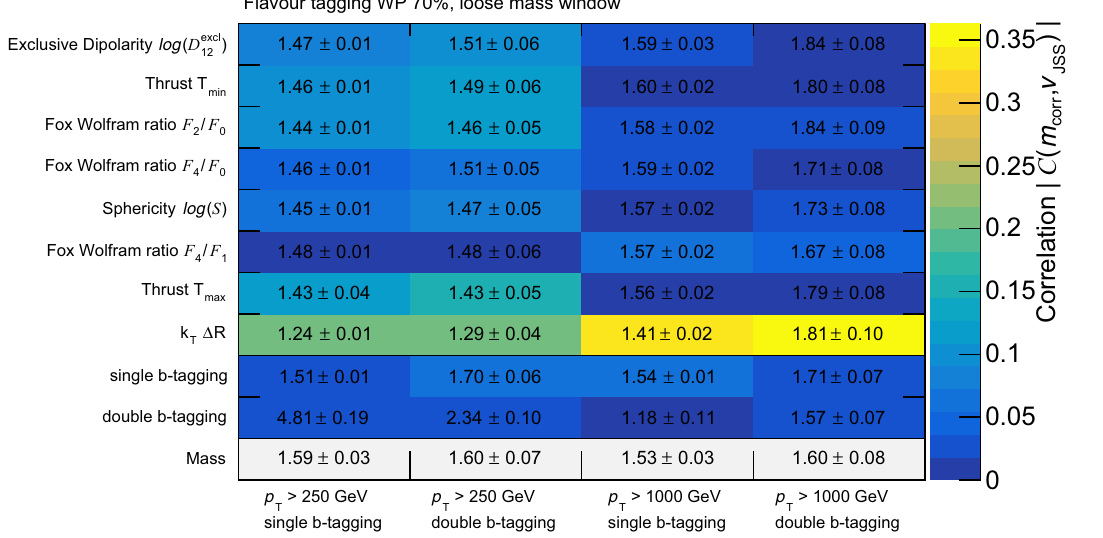
correlationcoefficient, | C ( m corr ,v JSS ) | ,betweenthejetmassandthejet substructure variables. The selection efficiency is determined relative to the mass window and b -tagging benchmark working points defined in Sects. 6.3 and 6.2